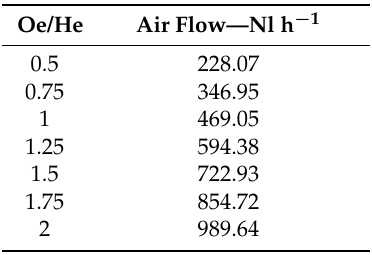
Table 2. Air flow values used for the study.